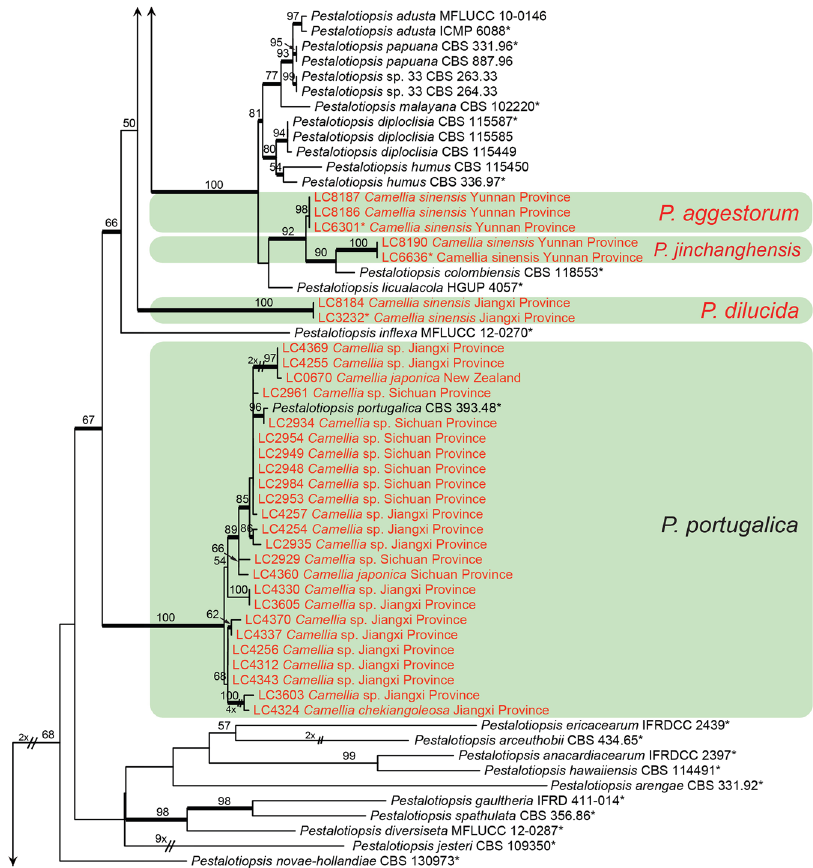
Figure 3. Part b of the phylogenetic tree of Pestalotiopsis , followed by Fig.